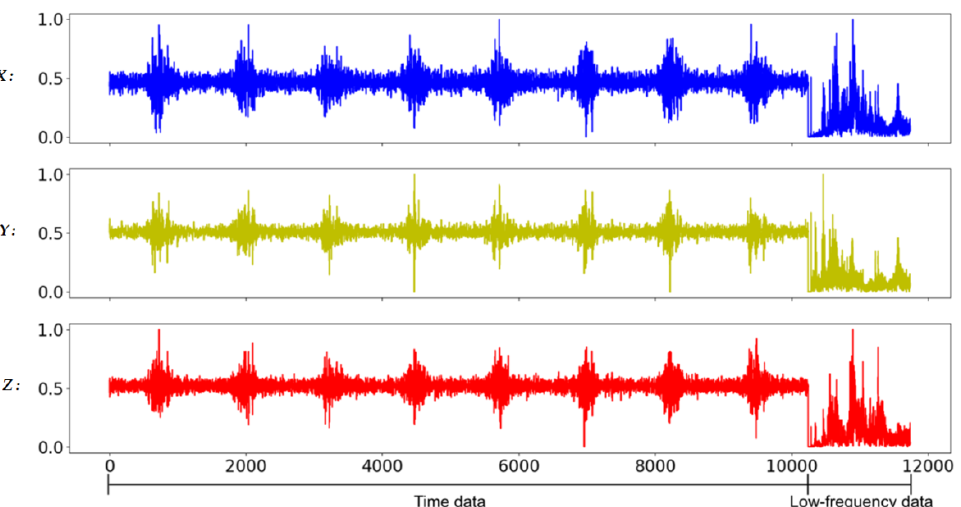
Figure 10. Full-frequency (FF) data.